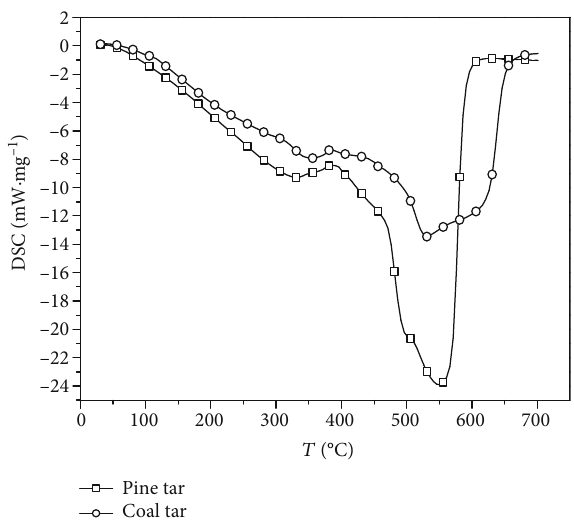
Figure 3: Thermal weight loss rate curve of test samples.